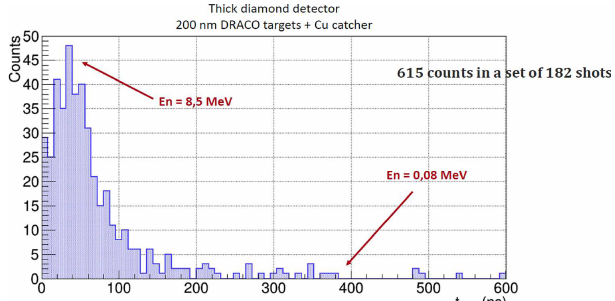
Fig. 4. Single particle neutron time-of-flight spectrum mea- sured with the DRACO PW Laser using 182 laser shots. The flight path from the catcher target to the diamond detector was 145 cm. (Courtesy M. Millan Callado PhD thesis in prepa- ration, Univ. of Seville, 2022).